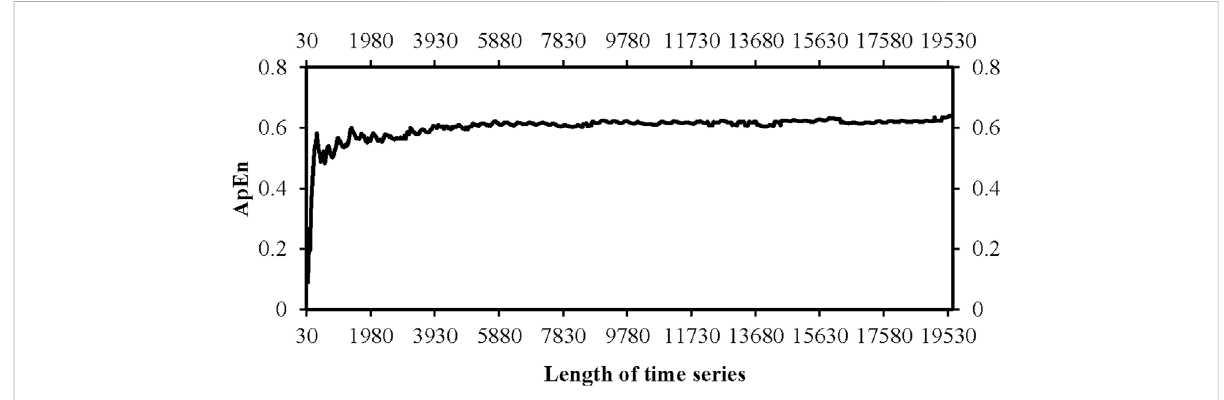
FIGURE 3 ApEn of daily precipitation at the Jinan station with the data length increasing from 30 to